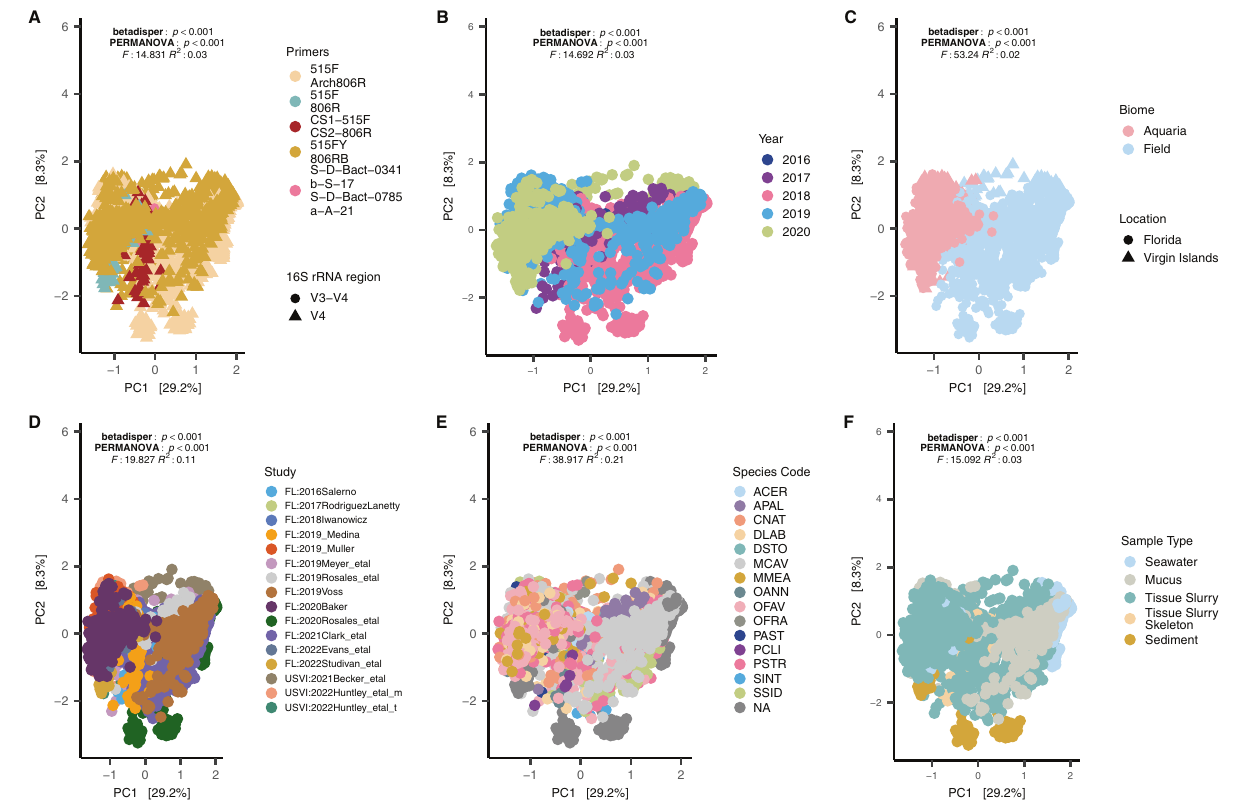
Fig. 3 Microbial beta-diversity of all coral species (stony coral tissue loss disease [SCTLD]-susceptible corals and Acropora spp.) and sample types (coral, sediment, and seawater) show differences within and between microbial communities. A small subunit (SSU) 16S rRNA gene primers, B year, C biome, D study, E coral species, and F sample type. All plots were centered log-ratio transformed and visualized with a Euclidean distance. The NAs in ( E ) represent sediment and seawater samples; coral species codes are de fi ned in Fig. 1